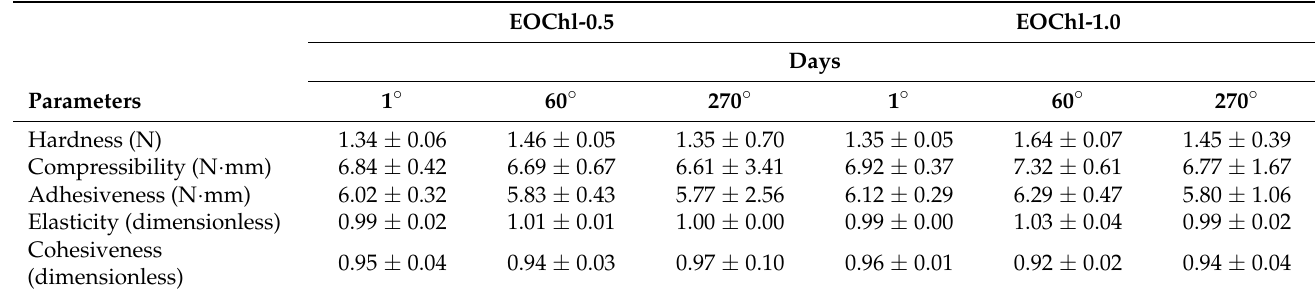
Table 3. Mechanical properties at 25 ◦ C, obtained 60 and 270 days after preparation.